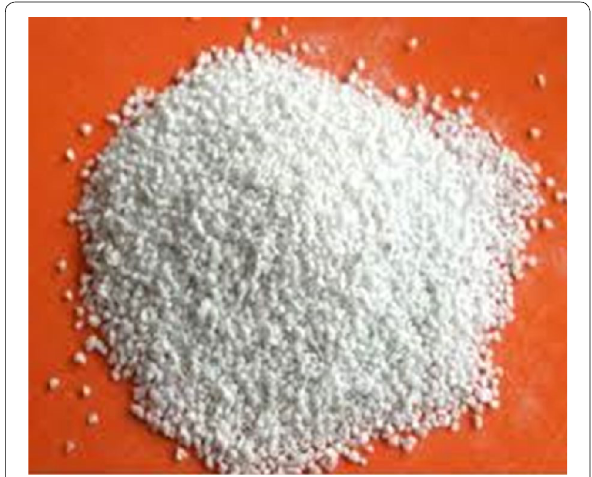
Fig. 1 Expanded perlite aggregate.